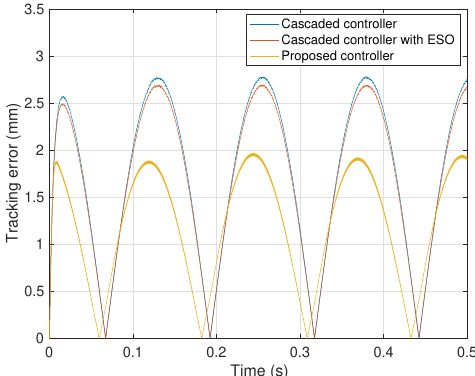
Figure 9. Tracking error comparison based on three different controllers.